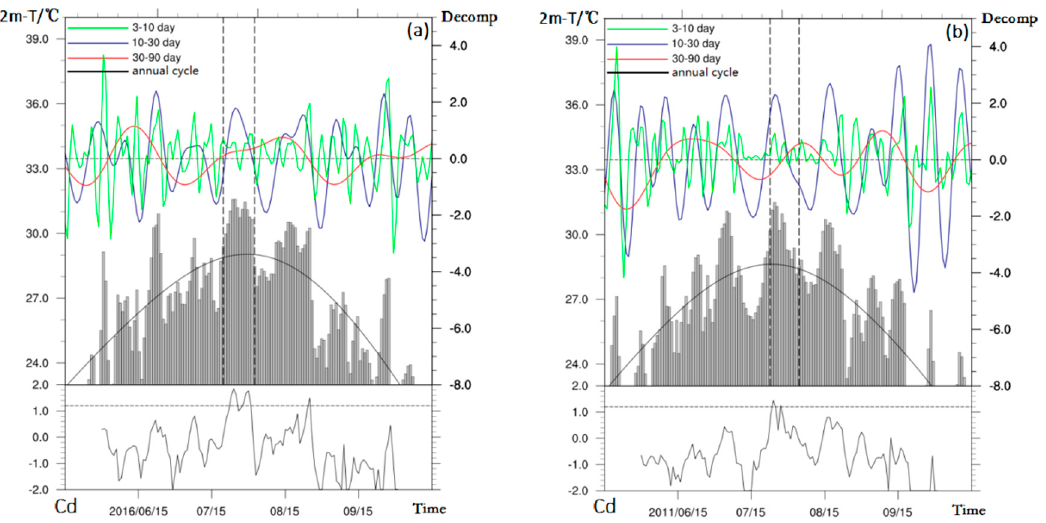
Figure 2. Same as Figure 1, but for two typical EHW events persisting less than 15 days, respectively, in ( a ) 2016 and ( b ) 2011.